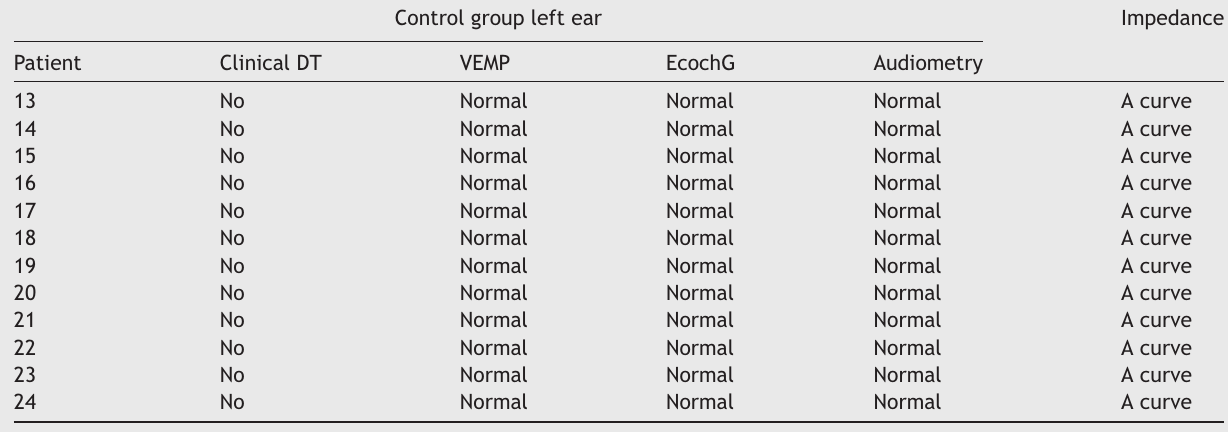
Individual results of the left ear in the control group.